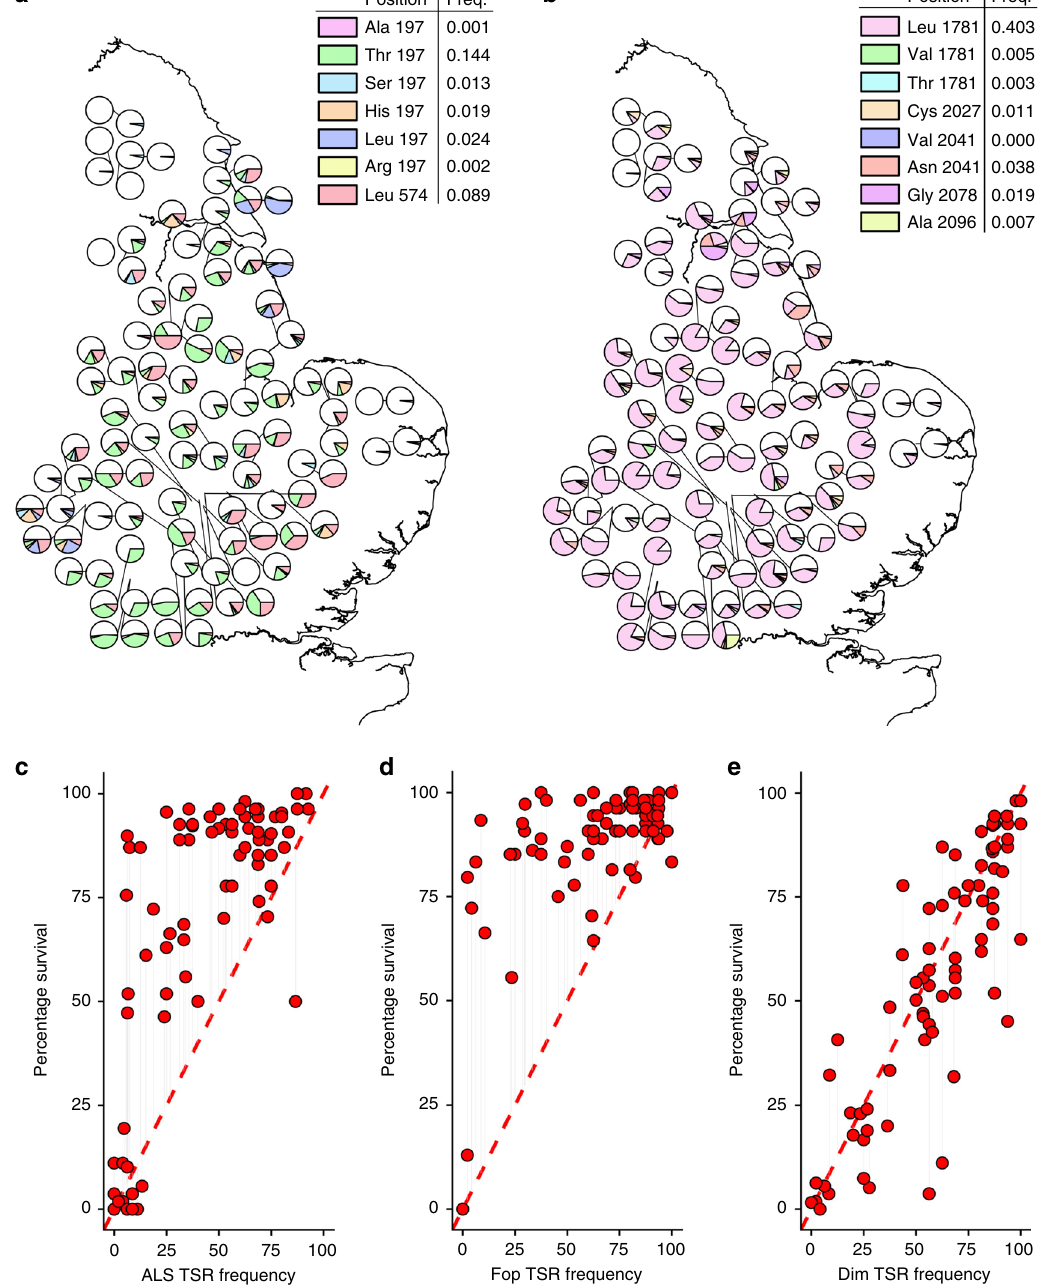
Fig. 2 Contribution of ALS and ACCase target-site mutations to herbicide resistance across UK A. myosuroides populations. a , b Show the geographic distribution and relative frequency of amino acid substitutions in the ALS gene and ACCase gene, respectively. White portions of the pie charts show the frequency of wild-type sequence, while coloured portions represent the relative frequencies of each amino acid substitution. ‘ Freq ’ within the legend shows the overall allele frequency for each mutation across all tested populations. TSR genotype information was determined from ≥ 16 plants per population. Panels ( c – e ) show the observed proportion of individuals surviving herbicide ( Y -axis) versus the proportion of individuals carrying a TSR resistance mutation ( X -axis) for the ALS (SU), Fop and Dim herbicides, respectively. An expected 1:1 relationship is shown by the diagonal line. Points above the 1:1 line implicate the coexistence of TSR and NTSR mechanisms in respective populations. Source data are provided as a Source Data fi